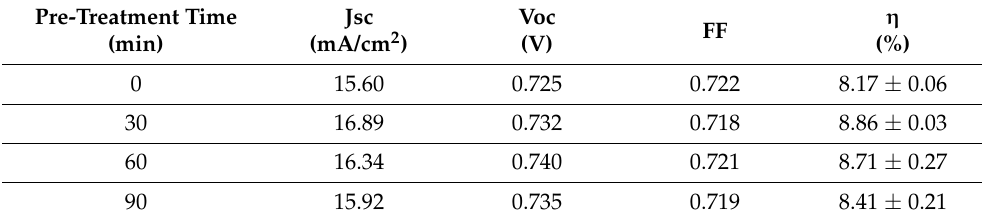
Figure 2. FTO glass pre-treatment by TiCl 4(aq) for different times. ( a ) CV analysis and ( b ) Transmittance measurement. Table 1. Performance of devices at different TiCl 4(aq) pre-treatment time.